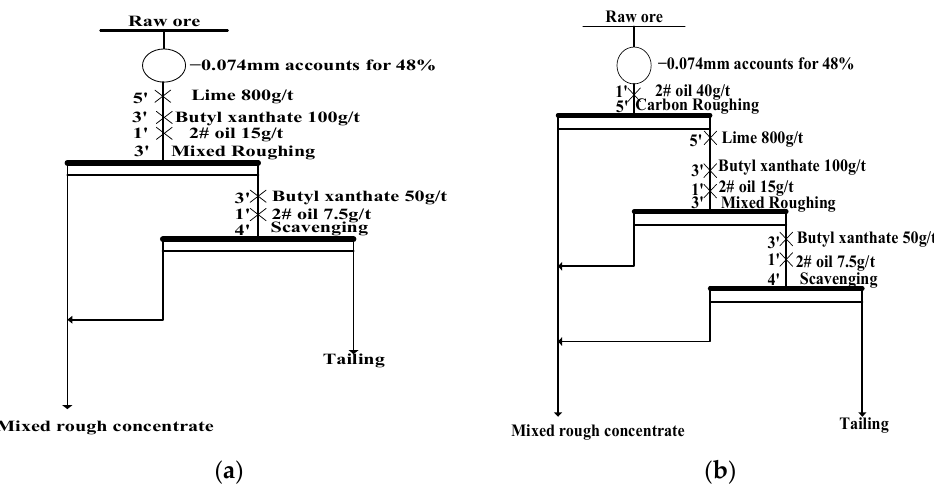
Figure 8. The flow sheet for flotation experiments. ( a ) Undecarbonized; ( b ) Decarburized.